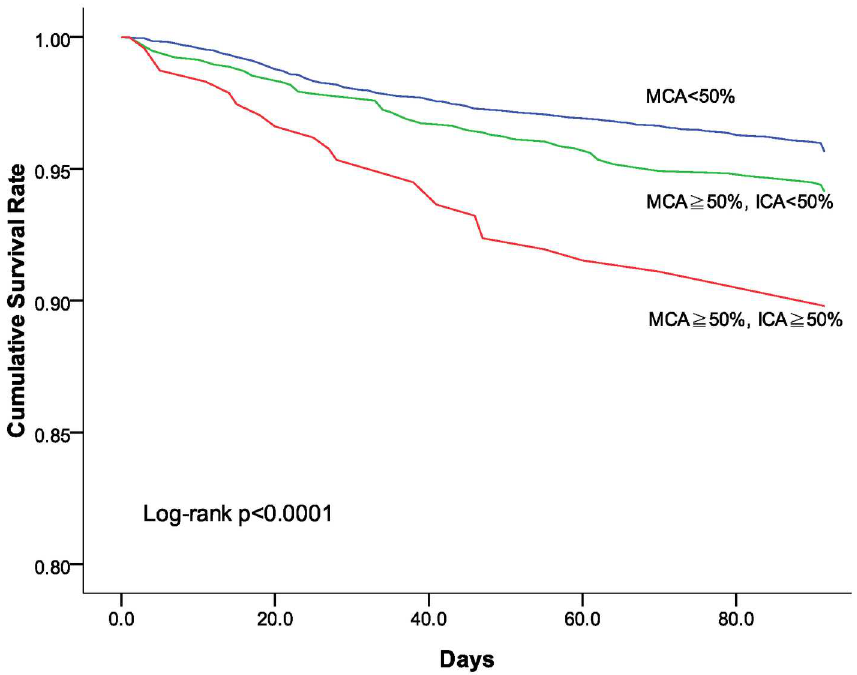
Fig 1. Cumulative survival (free of recurrentstroke or death) among patients with or without MCA stenosis.